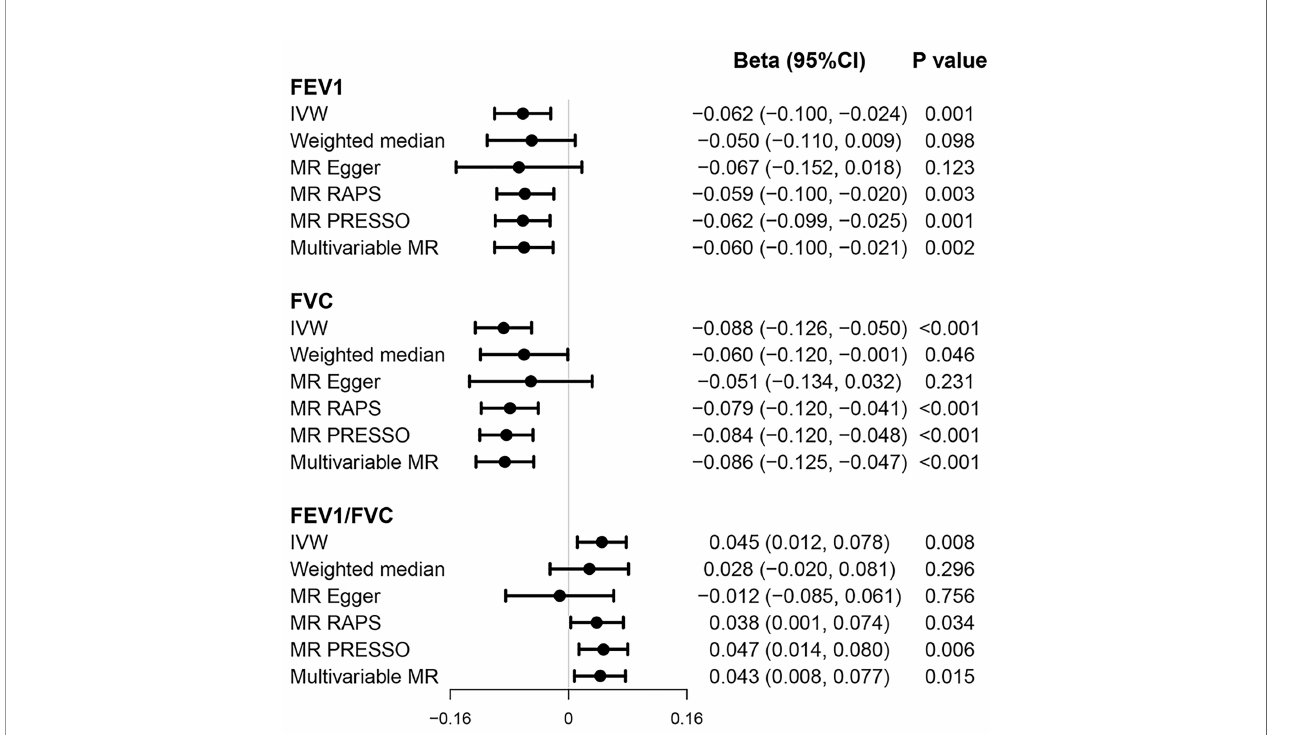
FIGURE 3 | Causal effects of T2D on pulmonary function. Beta (95% CI) represent per one-unit increase in log e odds of T2D. FEV1, forced expiratory volume in 1 s; FVC, forced vital capacity; T2D, type 2